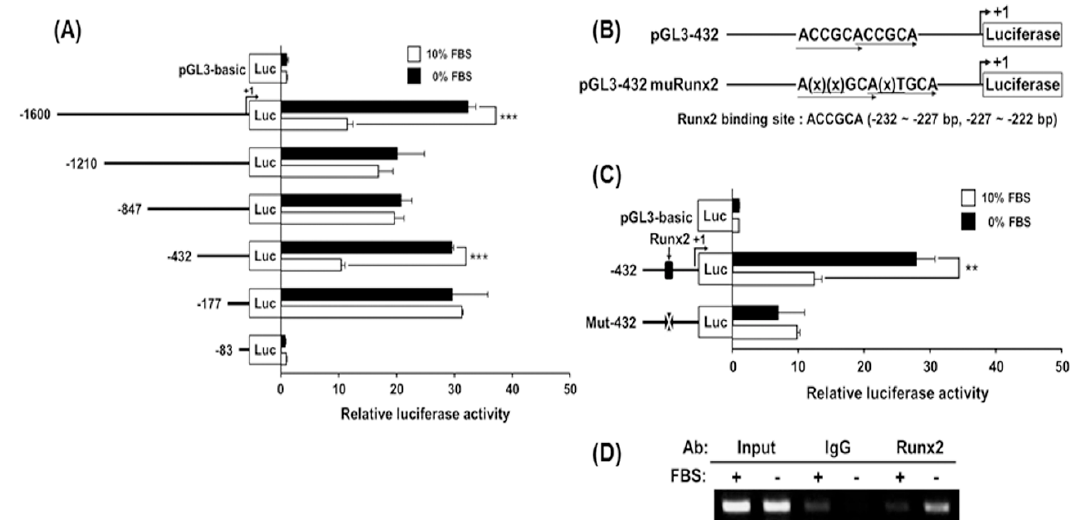
Figure 6. Analysis of the hST3Gal V promoter activity in SD-induced MG-63 cells. The schematic diagrams represent DNA constructs ( A ) containing various lengths of the wild-type hST3Gal V promoter or constructs ( B , C ) with the mutant Runx2 sequence in the 5 ′ -flanking region, upstream of a luciferase reporter gene; the transcription start site is designated +1. The pGL3-basic construct, which did not contain a promoter or an enhancer, was used as a negative control. Each construct was transfected into MG-63 cells, with pRL-TK co-transfected as an internal control. The transfected cells were incubated in the presence (open bar) or absence (solid bar) of 10% FBS for 24 h. Relative firefly luciferase activity was measured using the Dual-Luciferase Reporter Assay System, and all firefly activity was normalized to the Renilla luciferase activity derived from pRL-TK. The values represent the means ± SD of three independent experiments with triplicate measurements. ** p < 0.01; *** p < 0.001; ( D ) PCR amplification in the − 432 and − 177 region of the hST3Gal V promoter on chromatin immunoprecipitated with either an antibody against Runx2 or control IgG from MG-63 cells grown in the presence or absence of 10% FBS for 24 h. The input (10-fold diluted) represents the positive control.